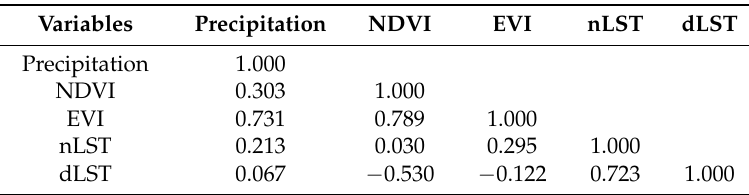
Table 3. The Pearson correlation between the remotely sensed environmental variables in Chitwan, Nepal (2010–2016).